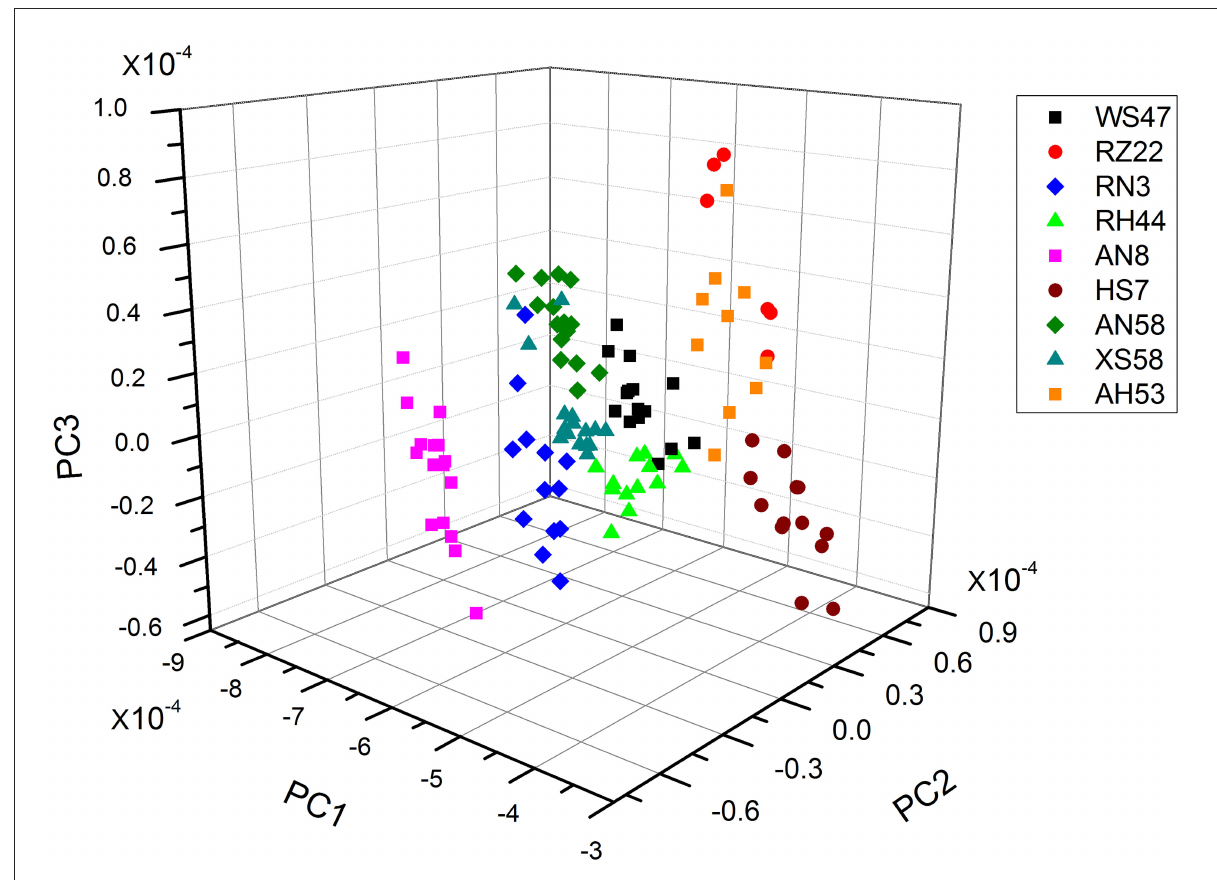
FIGURE4 PCA results of the carotenoids and lipids region (ca. 3,100–2,800 cm − 1